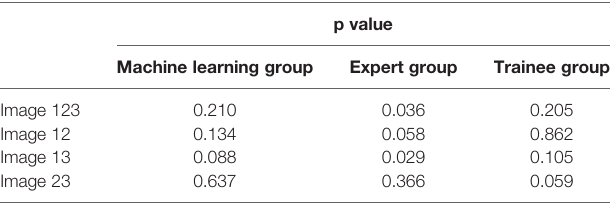
TABLE 2 | Differences between images within each group by qualitative grading